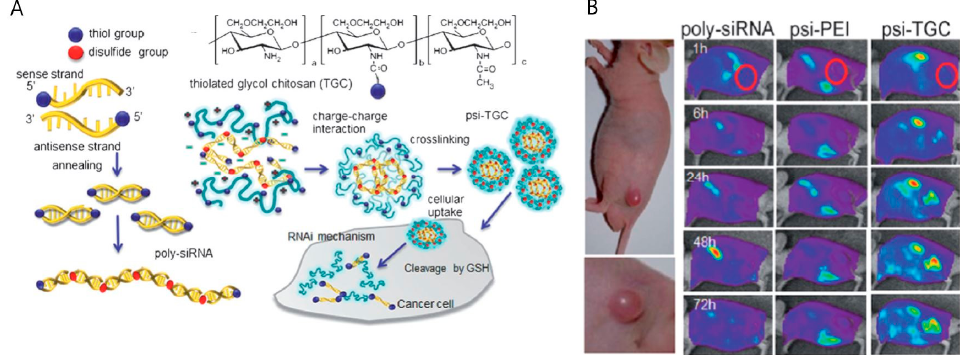
Figure 8. ( A ) Schematic diagram of poly-siRNA and poly-siRNA/glycol chitosan nanoparticle (psi-TGC); ( B ) whole-body images of tumor-bearing mice after injection with poly-siRNA, psi-polyethyleneimine and psi-TGC, respectively. psi-TGC showed longer circulation in the body and more accumulation at the tumor site, indicated by red circles (Adapted with permission from [59]. Copyright 2012 WILEY-VCH Veriag GmbH & Co. KGaA, Weinheim).